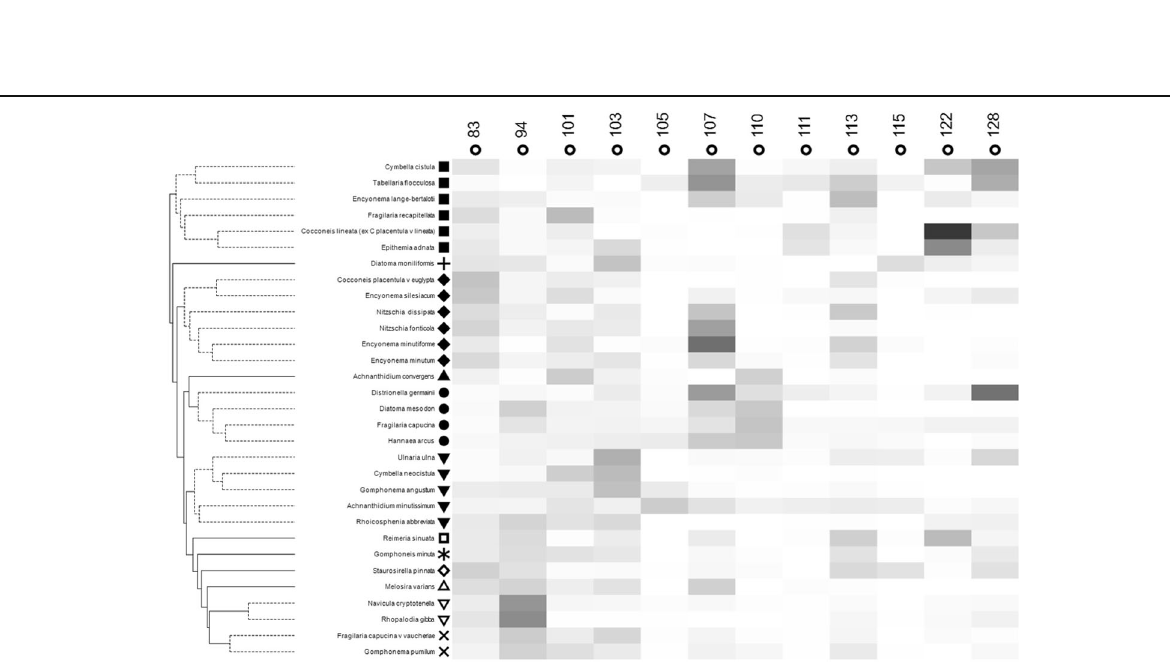
Fig. 6 Shade plot showing the distribution of density of the species (listed at the left) with the greatest contibution to the structure of the groups of sites not invaded by D. geminata in the studied basins (numbers above the graph). The left side of the figure show the clustering with the significant groups (dashed lines) identified by SIMPROF. Biobio River Basin (83), Tolten River Basin (94), Valdivia River Basin (101), Bueno River Basin (103), Puelo River Basin (105), Yelcho River Basin (107), Palena and coastal Rivers in the Southern Limit of the Tenth Region River Basin (110), Coastal and Island Rivers Between Palena River and Aysen River Basins (111), Aysen River Basin (113), Baker River Basin (115), Coastal Rivers Between Seno Andrew and Hollemberg River and Rivers to the East River Basins (122), and Tierra del Fuego